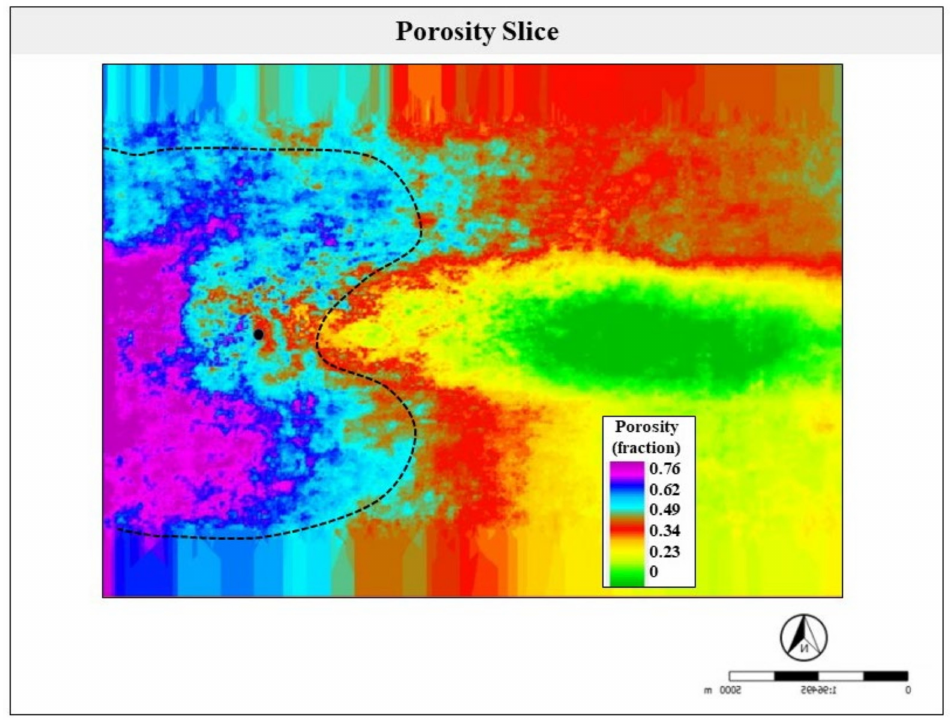
Figure 26. Averaged porosity data horizon slice within interval between Top H and H60